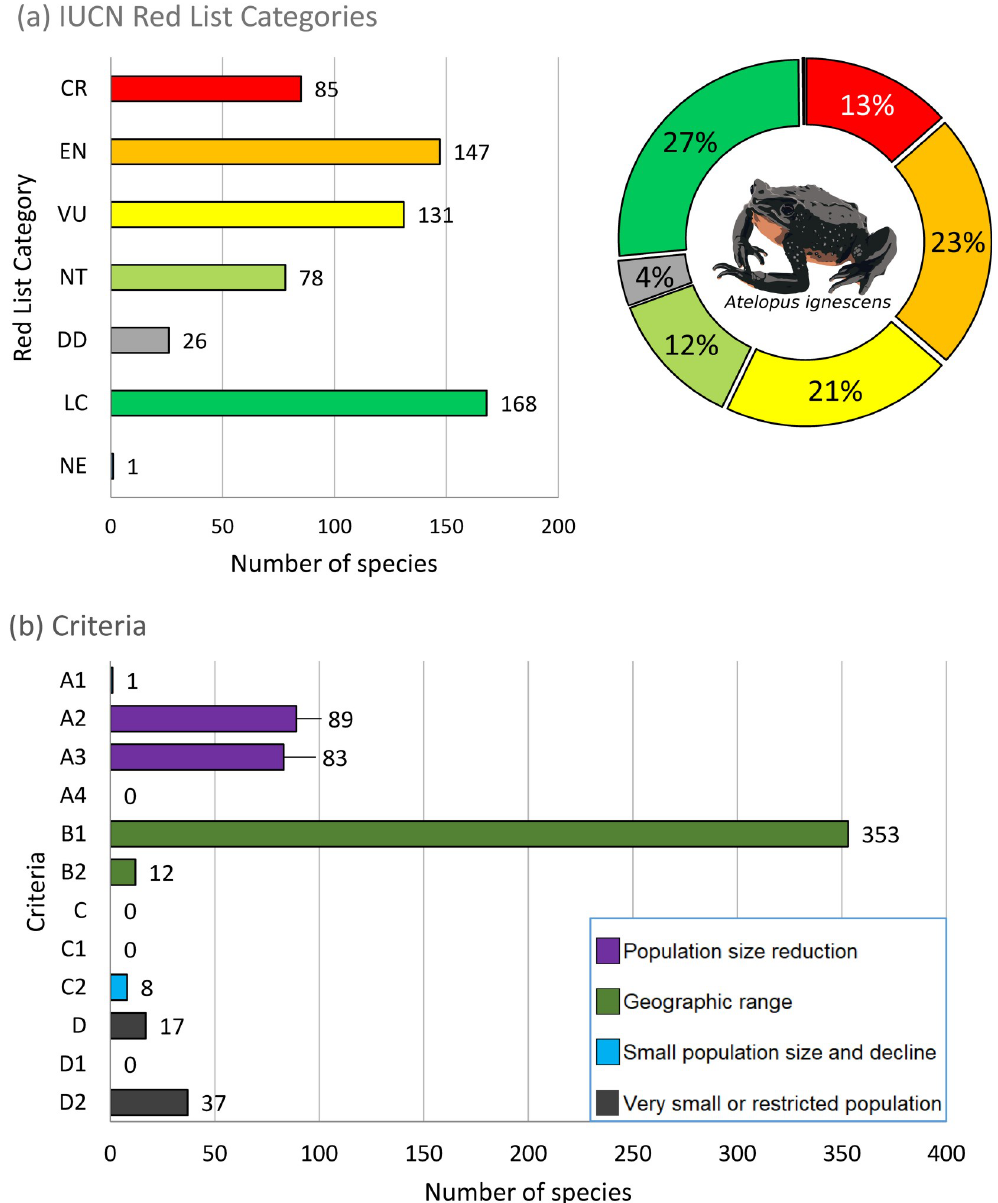
Fig 2. IUCN Red List of amphibians from Ecuador. The number of species by (a) Categories and (b) Criteria. Categories: CR = Critically Endangered, EN = Endangered, VU = Vulnerable, NT = Near Threatened, LC = Least Concern, DD = Data Deficient, NE = Not Evaluated—corresponds to Rana catesbeiana , an invasive species in Ecuador. Atelopus ignescens (Critically Endangered) was believed to be extinct until its rediscovery in 2016. Illustration by PARG.